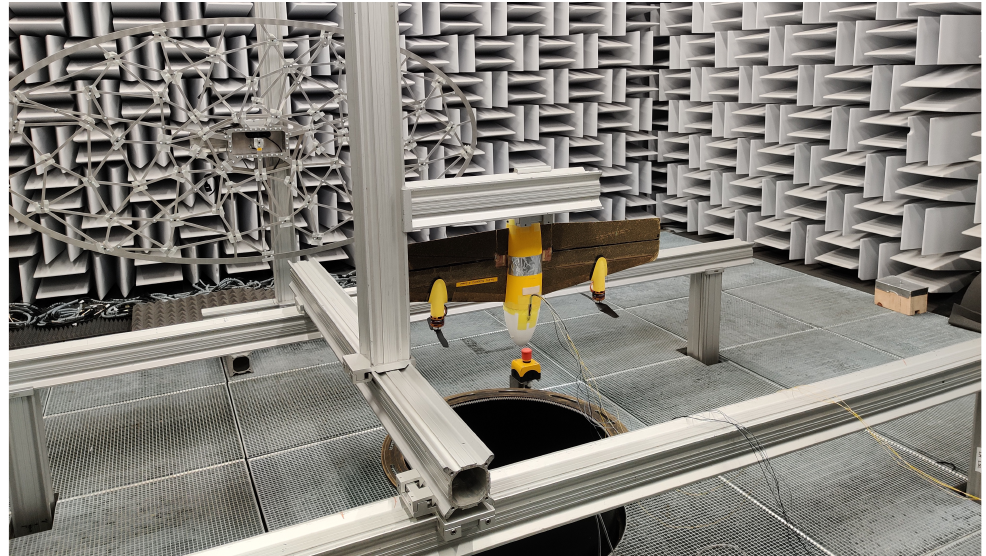
Figure 4. The Cyclone drone mounted on the Cyclone drone mounted on the rig in the A-Tunnel of the TU Delft’s Low-Speed Laboratory.